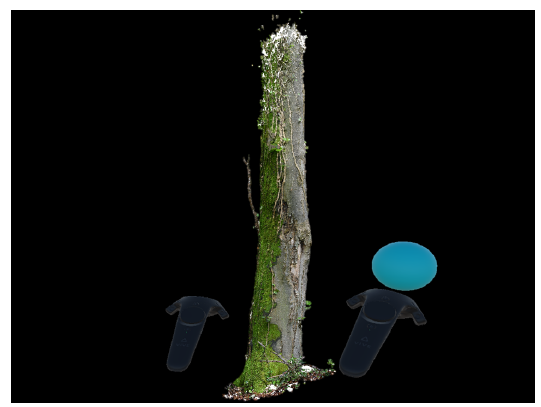
Figure 4. Tree stems before labelling process.